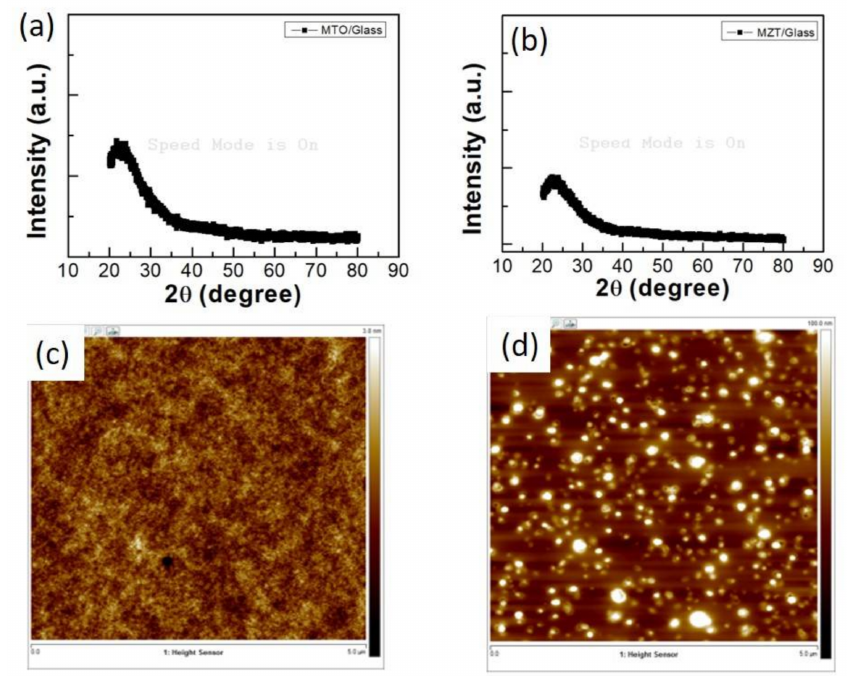
Figure 3. The XRD patterns of the ( a ) MTO and ( b ) MZT thin films deposited on the glass. An atomic force microscopy (AFM) image of the ( c ) MTO thin film and the ( d ) MZT thin film.